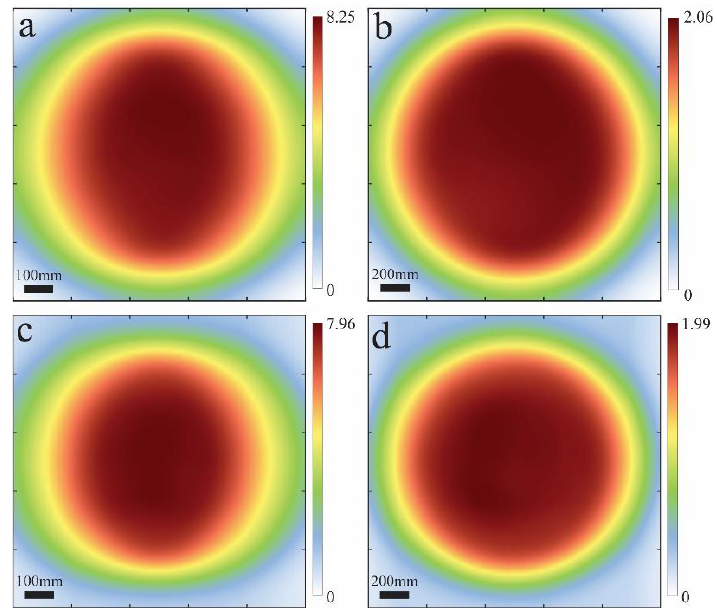
Figure 6. Simulation and experimental results for a 1 by 25 LED array, oriented along the x-axis. ( a ) Simulation result for a 1 m 2 target plane, located 25 cm away from the LED array. ( b ) Simulation result for a 4 m 2 target plane, located 50 cm away from the LED array. ( c ) Experimental result for a 1 m 2 target plane, located 25 cm away from the LED array. ( d ) Experimental result for a 4 m 2 target plane, located 50 cm away from the LED array.